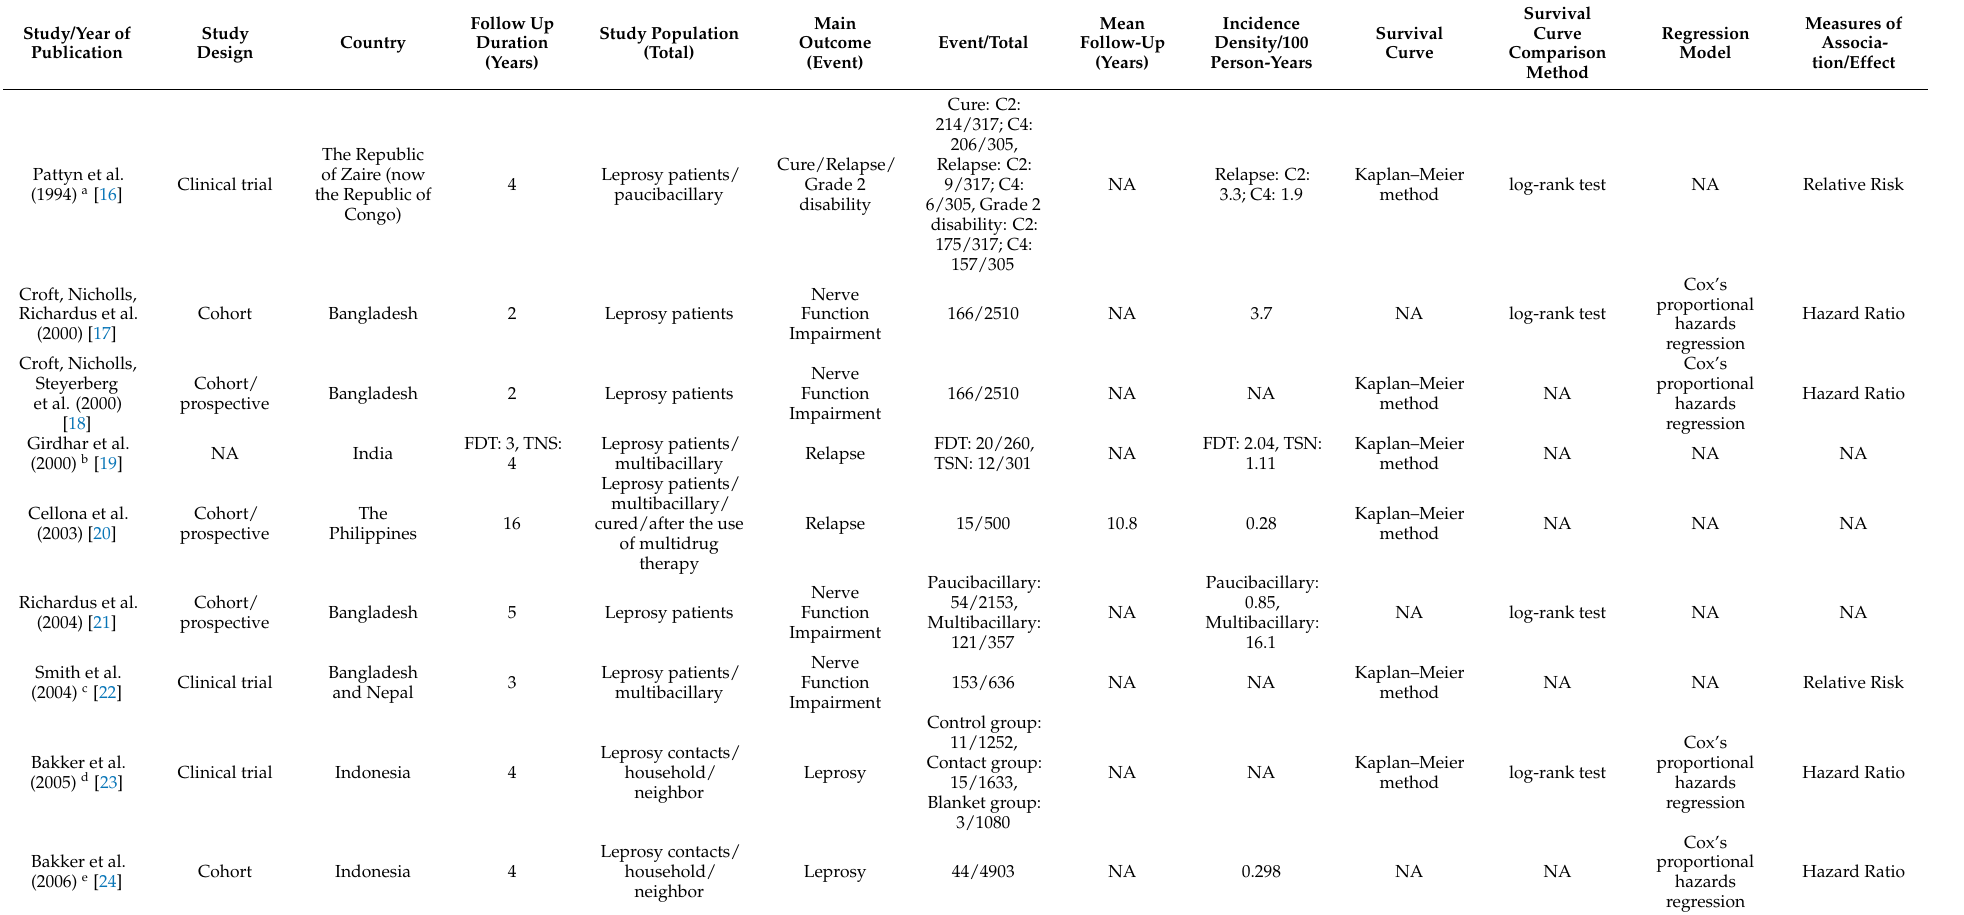
Table 1. Reporting survival analyses of the included studies.